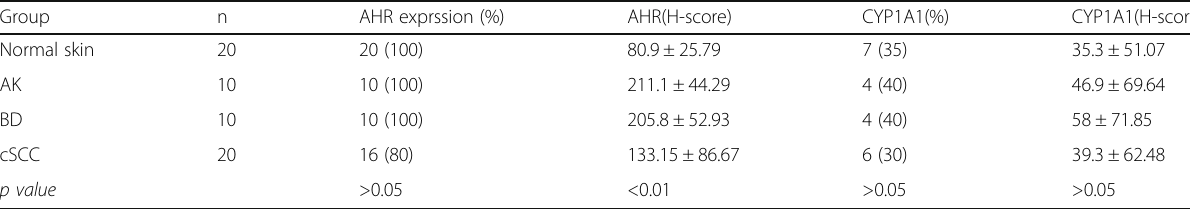
Table 2 Expression of AHR and CYP1A1 in NMSC and normal skin Group